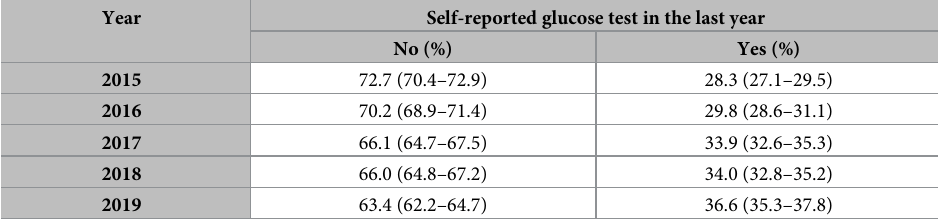
Table 2. Time trends of self-reported glucose tests in the last